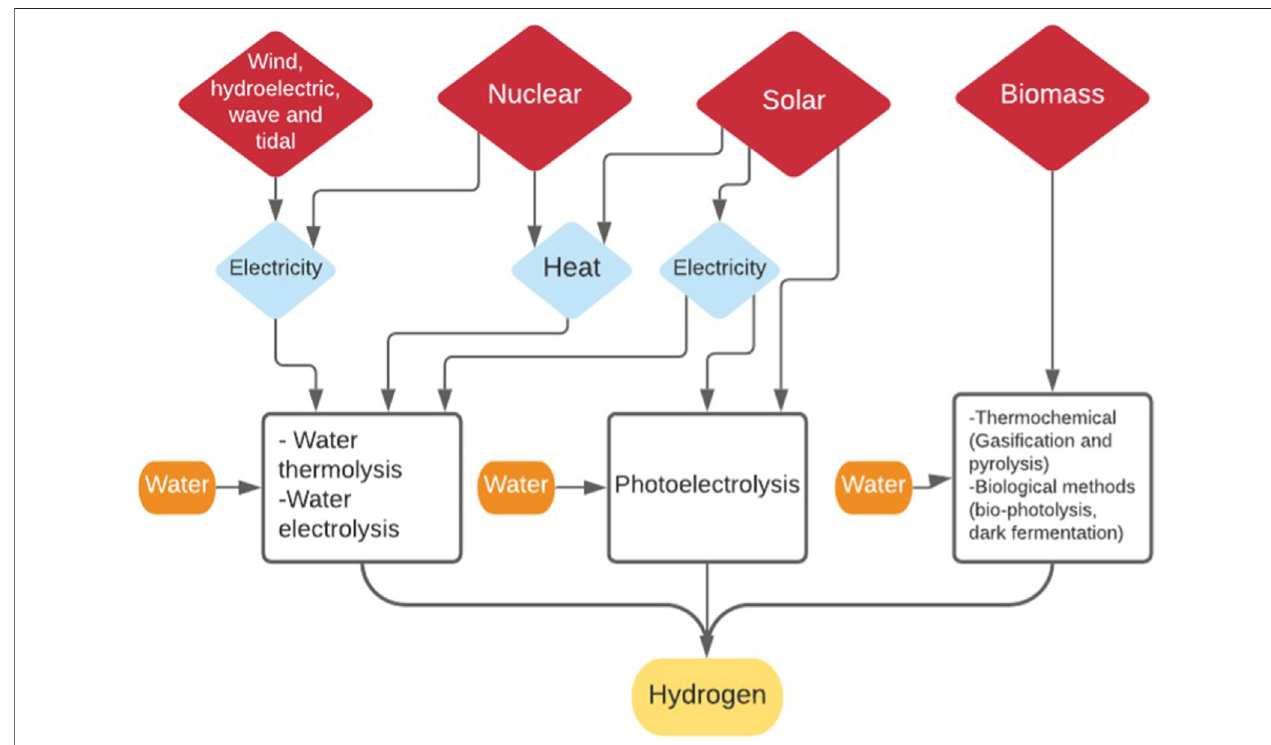
FIGURE 7 | Various routes for the sustainable (or low-carbon) production of hydrogen